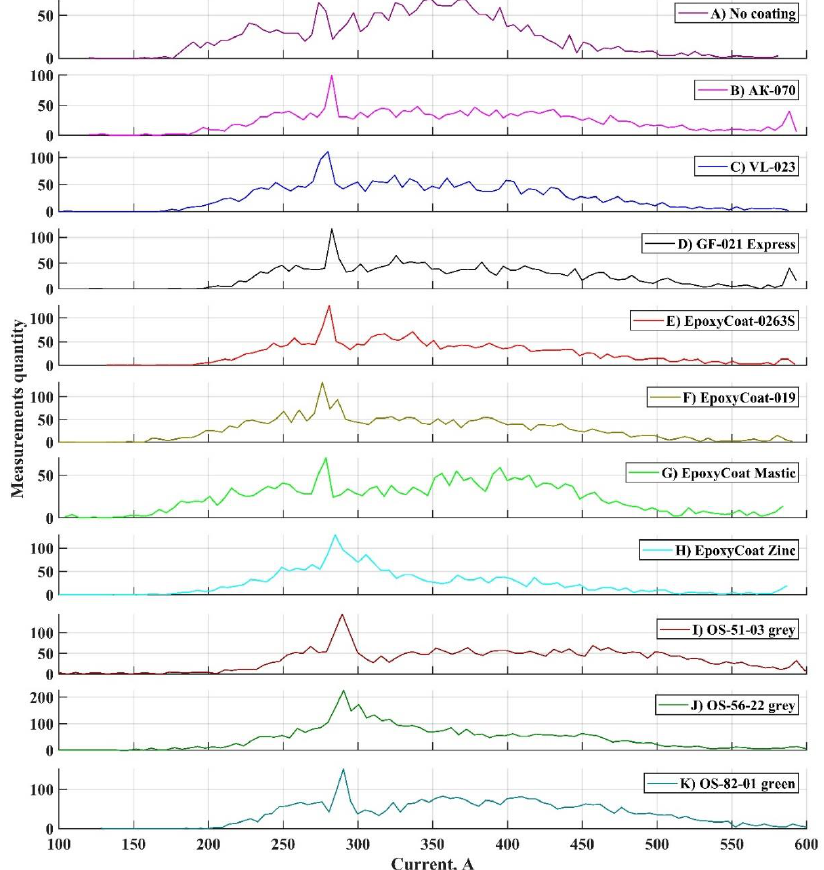
Figure 5. Profiles of peak short circuit current histograms: ( A ) No coating;( B ) AK-070; ( C ) VL-023; ( D ) GF-021 Express; ( E ) EpoxyCoat-0263S; ( F ) EpoxyCoat-019; ( G ) EpoxyCoat Mastic; ( H ) EpoxyCoat Zinc; ( I ) ОS -51-03 grey; ( J ) ОS -56-22 grey; ( K ) ОS -82-01 green.